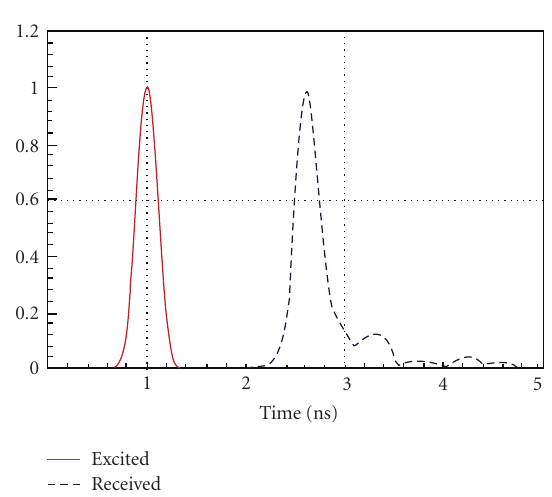
Figure 6: The measured gain and calculated radiation e ffi ciency of the antenna.